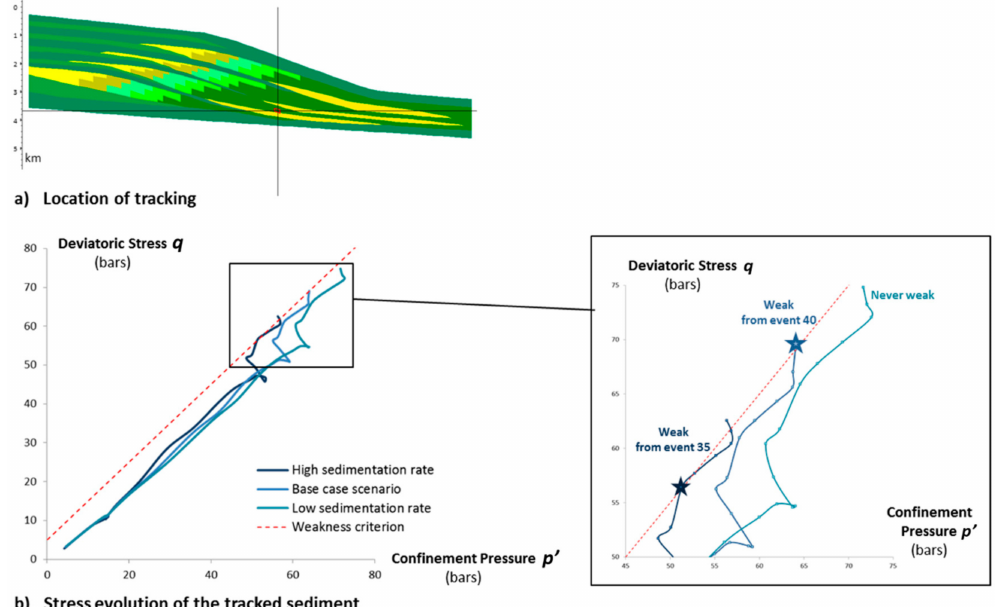
Figure 8. Influence of sedimentation rate on weakness development: locally. ( a ) location of the cell whose mechanical state was tracked through time; ( b ) evolution of the tracked cell in the p (cid:48) –q system for the three scenarios. The rightmost curve corresponds to the low rate scenario and the leftmost curve to the high rate scenario. The weakness criterion is reached earlier in the high rate scenario due to higher fluid pressure resulting in lower confinement pressure.